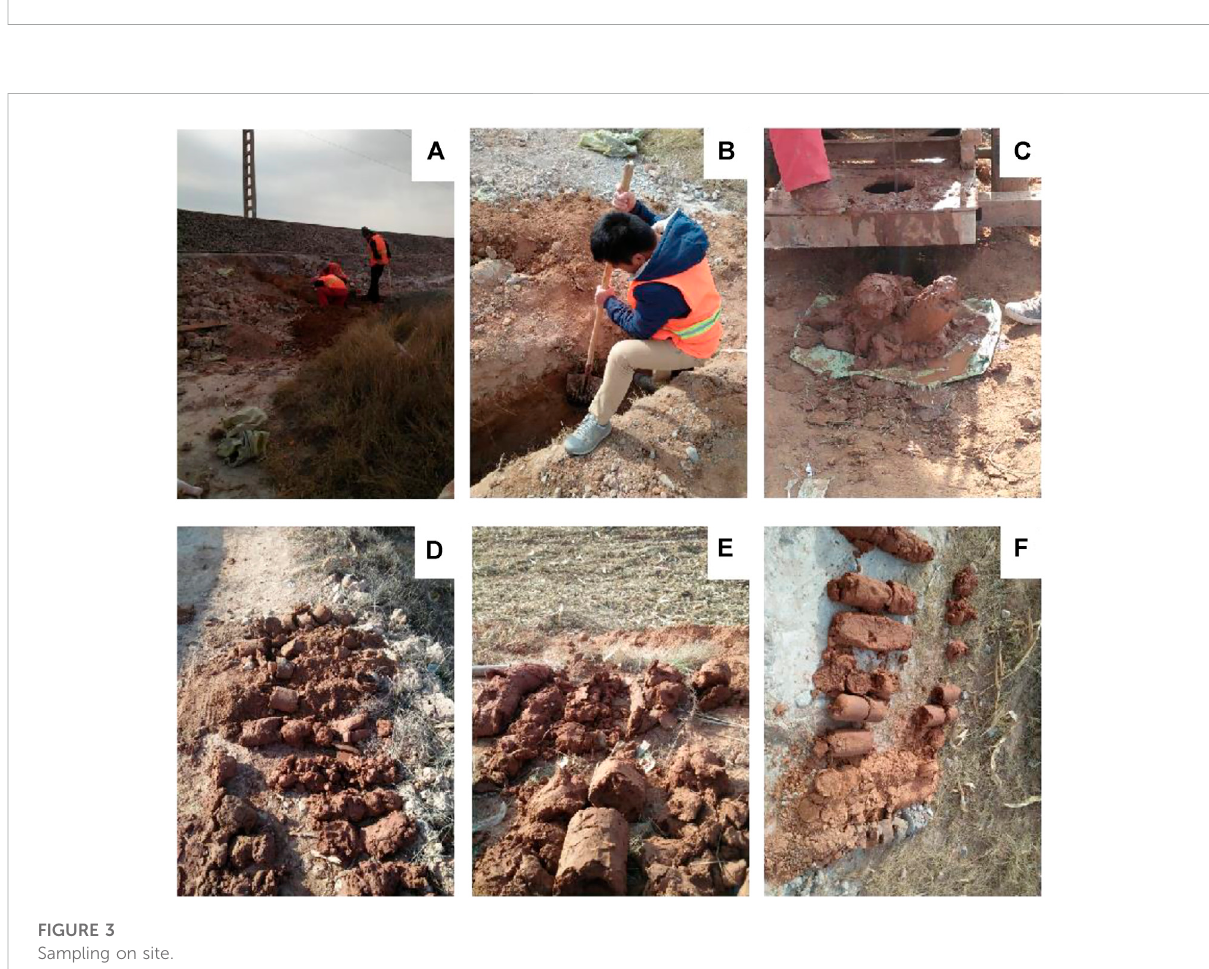
FIGURE 3 Sampling on